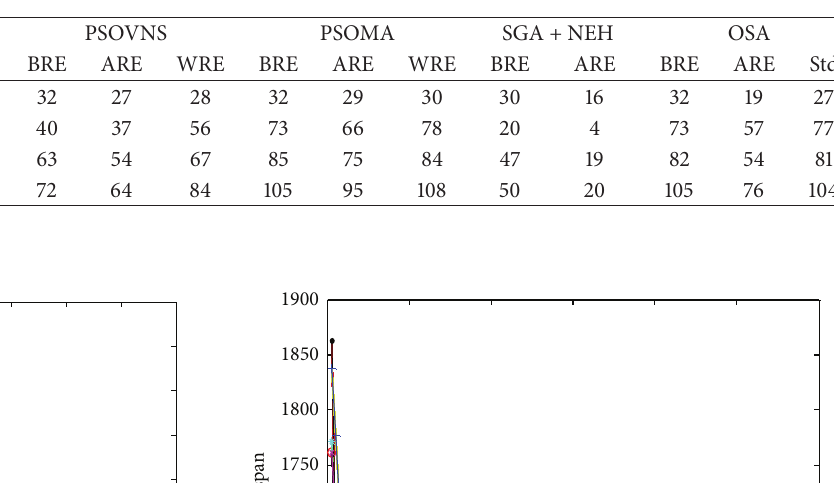
Table 4: The statistical results of score.